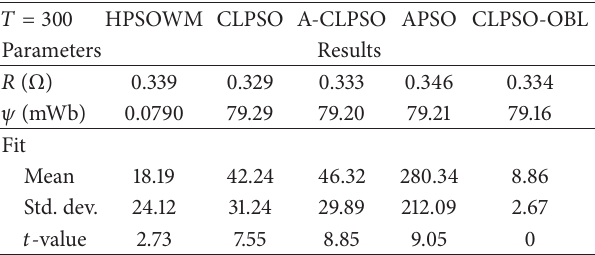
Table 1: Result of PMSM parameter estimation under normal temperature